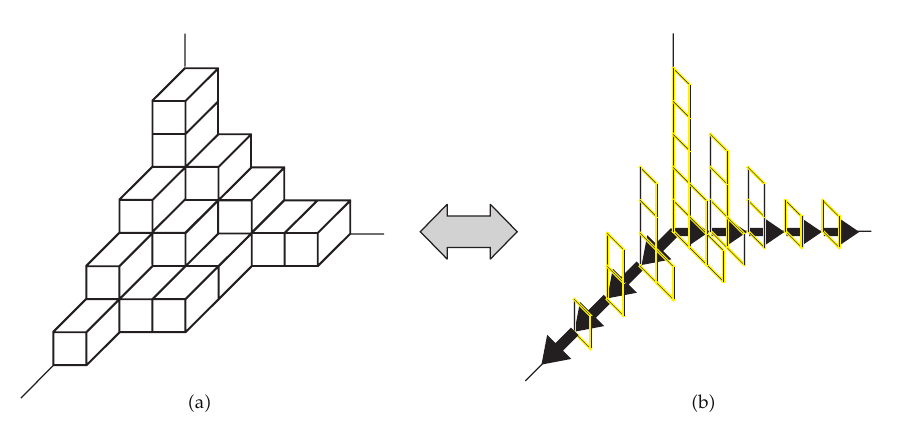
Figure 7: Slicing of a plane partition (cid:4) a (cid:5) into a sequence of interlacing two-dimensional partitions (cid:4) b (cid:5) . A sequence of Γ ± operators in (cid:4) 4.1 (cid:5) which create two-dimensional partitions is represented by arrows inserted along two axes. Directions of arrows → represent interlacing condition (cid:16) on partitions. We reconsider this example from a new viewpoint in Figure 10.